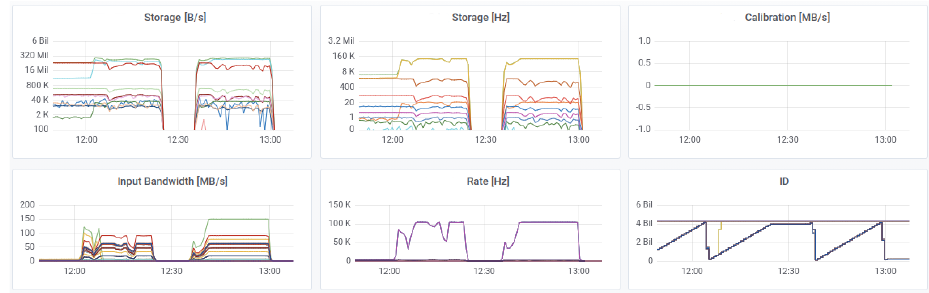
Figure 4. A fragment of a typical PBEAST Grafana